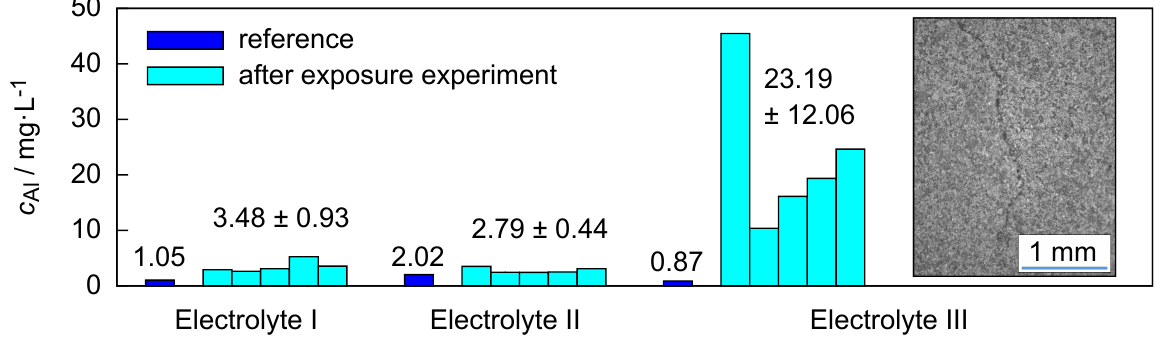
Figure 3. Aluminum concentrations of the electrolytes I-III used for the exposition experiments: reference concentration after preparing the solutions (blue), concentrations after immersing the 5 mounted samples for 60 min at 95 ◦ C